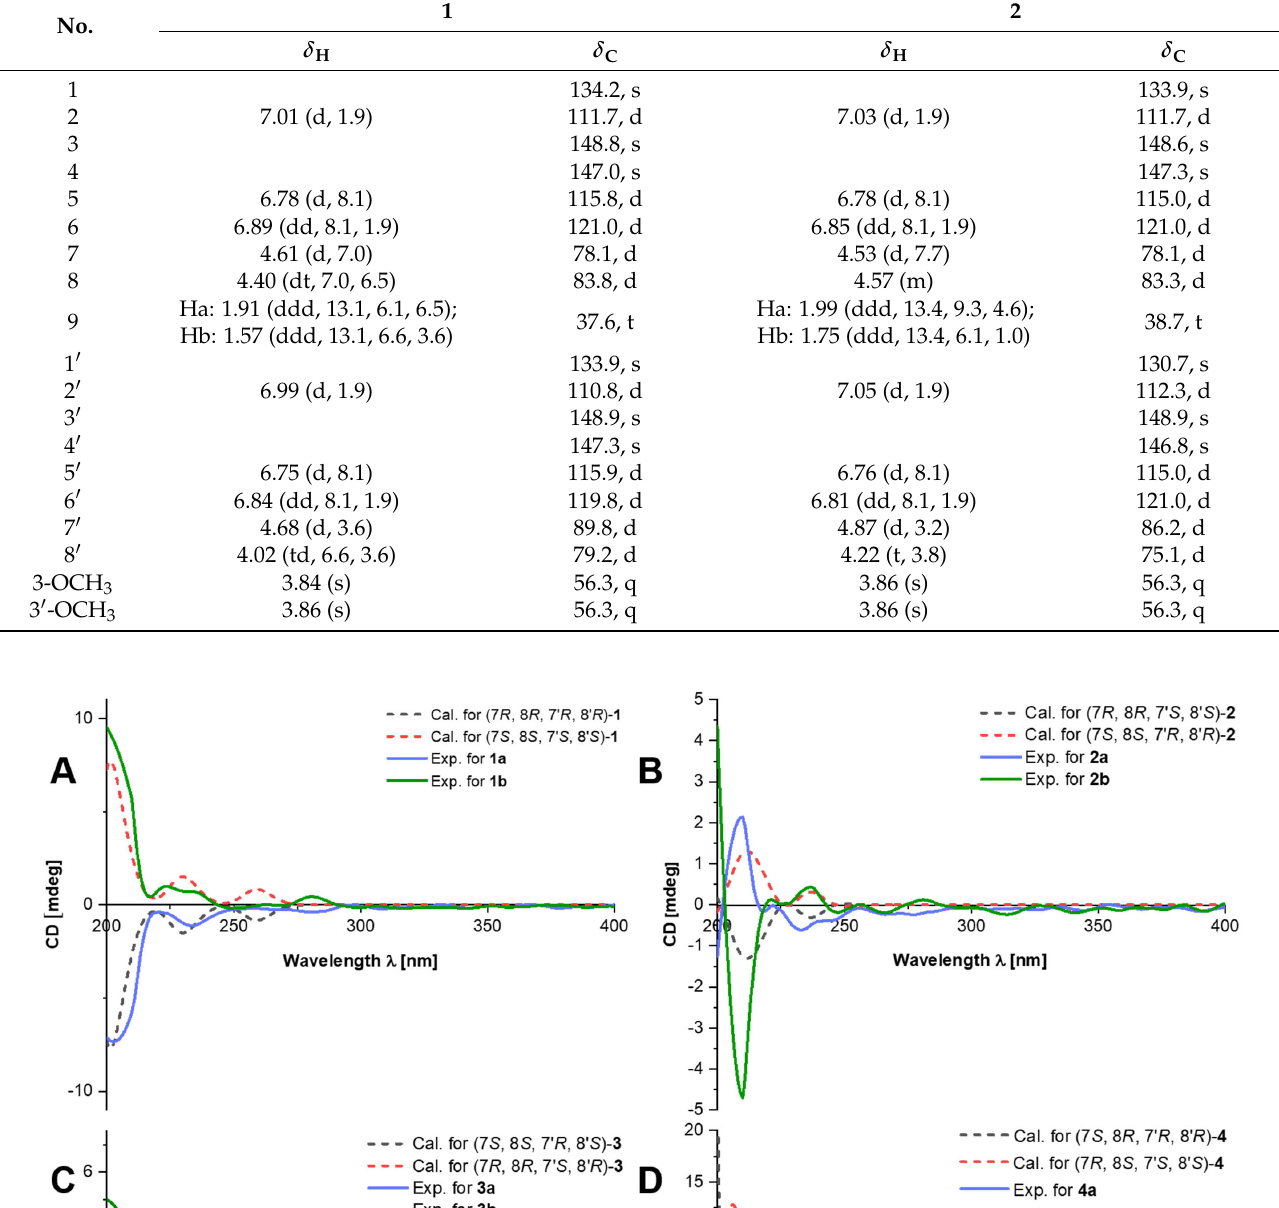
Table 1. 1 H (600 MHz) and 13 C (150 MHz) NMR data of 1 and 2 in MeOD ( δ in ppm, J in Hz).